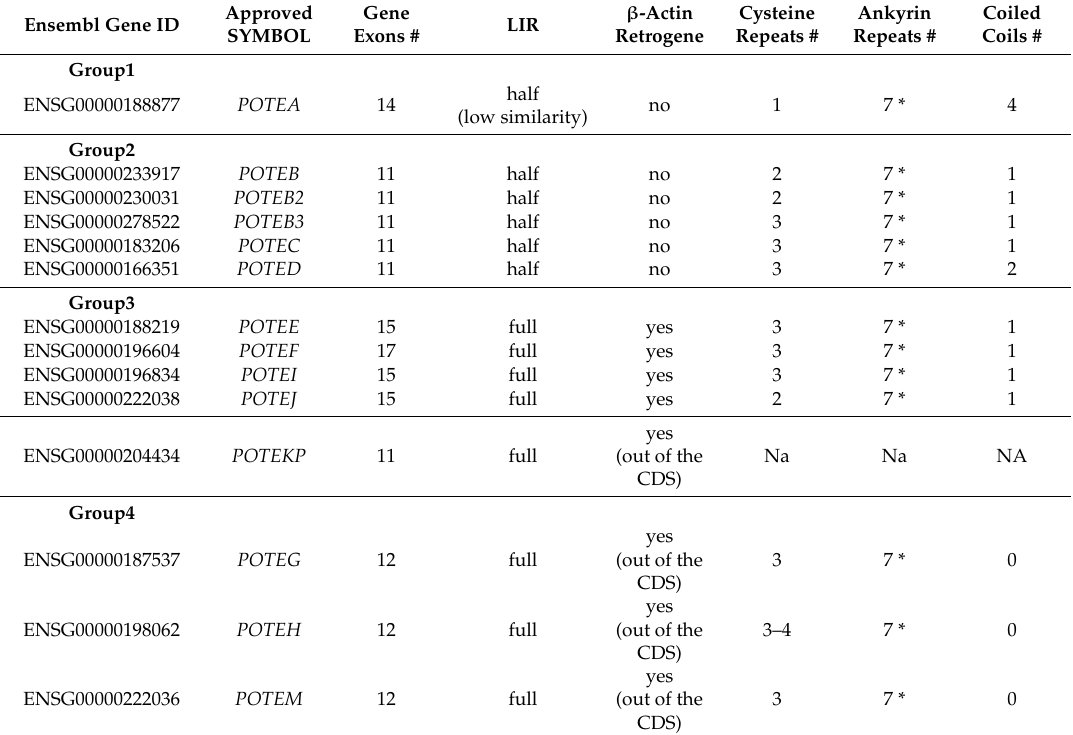
Table 2. Human POTE gene features and